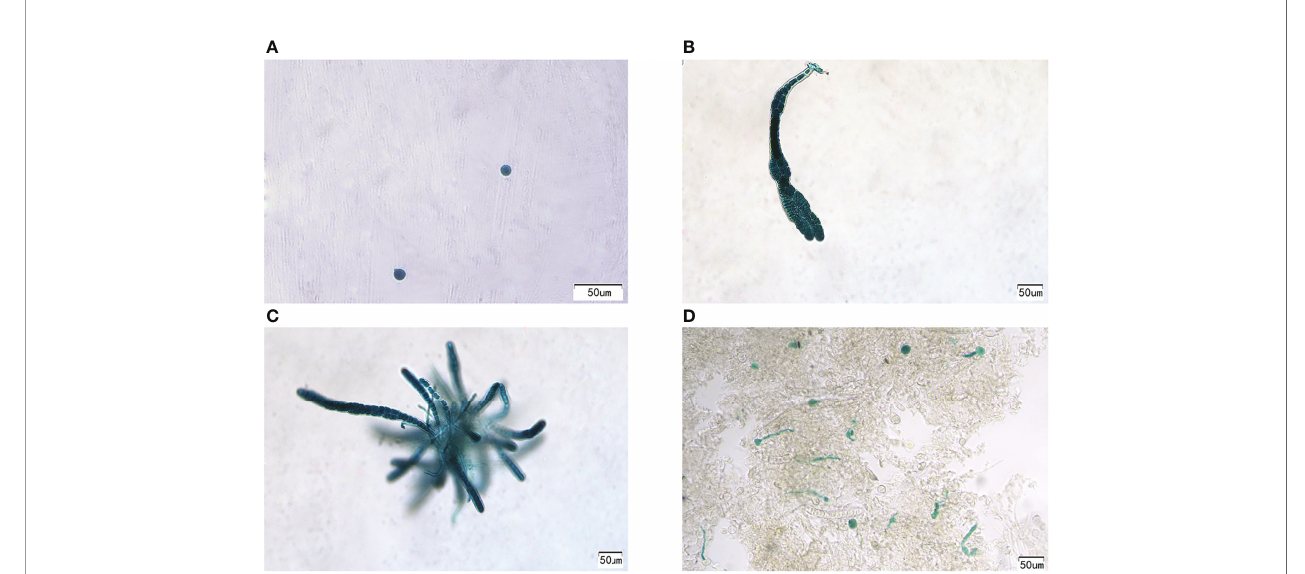
FIGURE 4 | Expression of PyGUS in gametophytes and sporophytes from the transformants. PyGUS was expressed in monospores (A) , thalli (B , C) , and fi laments (D) . Scale bars indicate 50 m